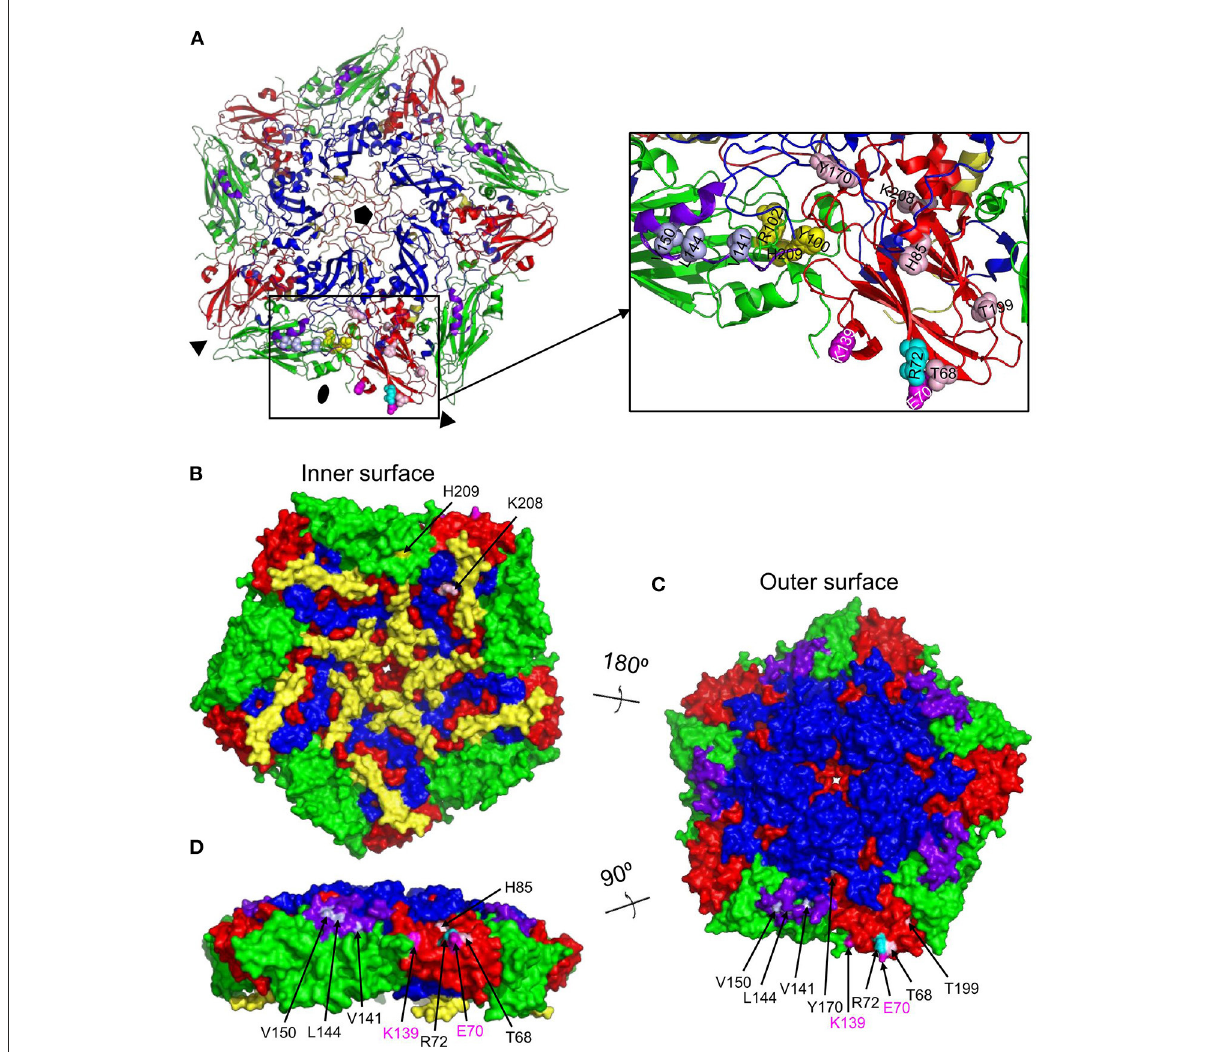
FIGURE5 Surface accessibility of M691F cross-linked residues mapped on a 12S pentamer of the A22IRQ structure (PDB: 4GH4) with superimposed GH loops of reduced O1K (PDB: 1FOD). The M691F cross-linked residues forming a single antigenic site on the protomer at the bottom is shown as a cartoon graph (A) . Side chains of cross-linked residues are shown as light blue (VP1) yellow (VP2) or cyan/pink (VP3) spheres. The surface accessible area of a pentamer (B, C) is shown for the inner surface (B) , outer surface (C) or from a side view looking at the 2-fold symmetry axis (D) . The 8 residues that are surface accessible are indicated by arrows (B–D) . VP1, blue; VP1 GH-loop, purple; VP2, green; VP3, red; VP4, yellow. The side chains of VP3-K139 and VP3-E70 that are mutated in mAb 9 escape mutants are indicated in magenta spheres. Fivefold symmetry axis, pentagon; 3-fold symmetry axis, triangle; 2-fold symmetry axis,